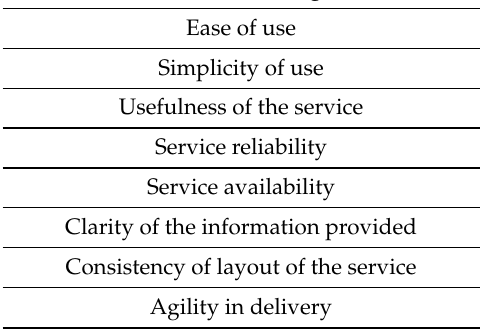
Table 4. Questionnaire applied for a survey of perception with experts.